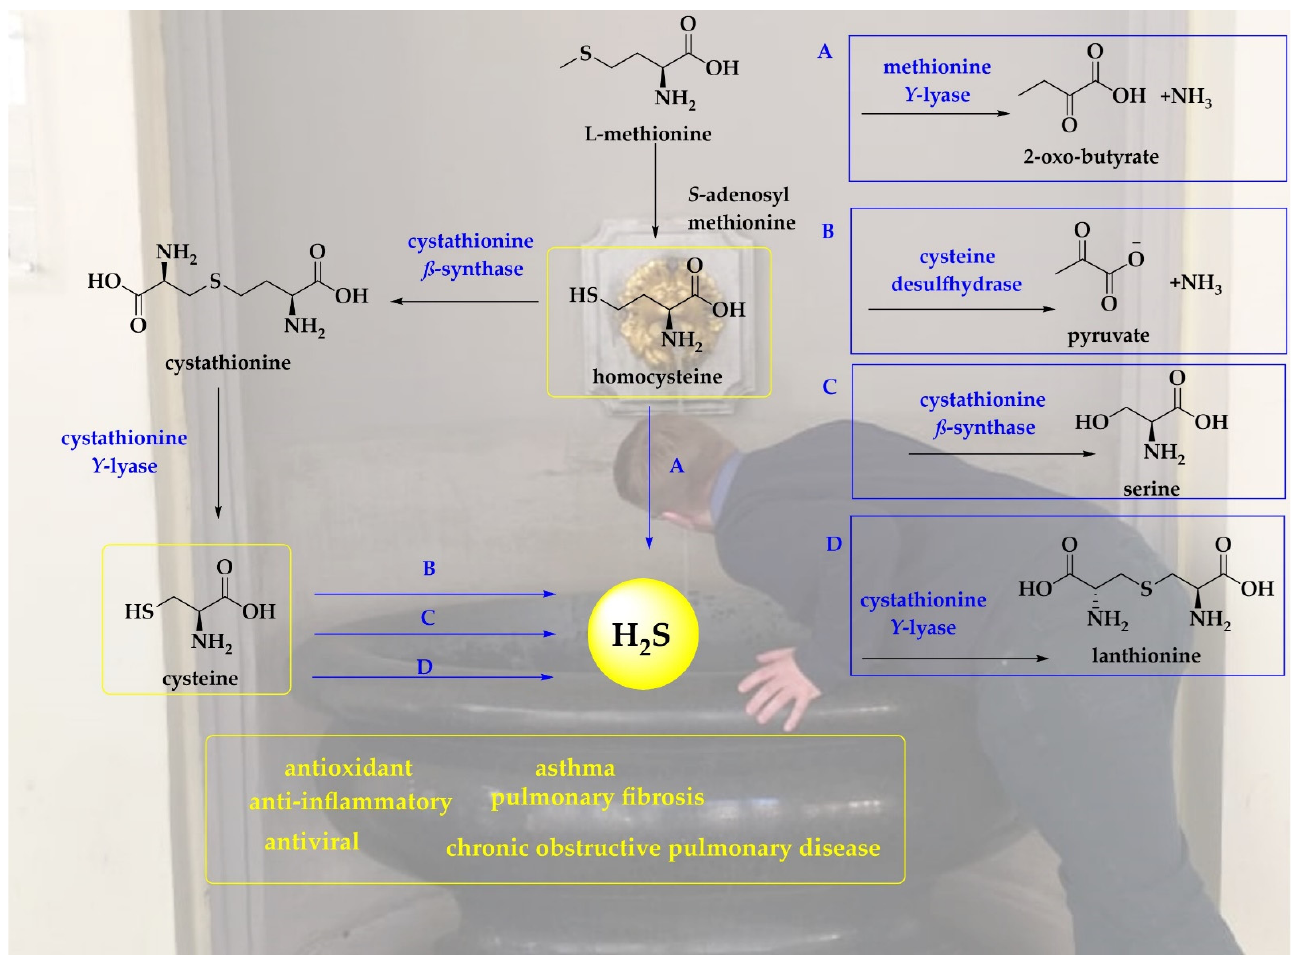
Figure 1. In mammals, H 2 S is produced via several pathways. Cystathionine- β -synthase (CBS) and cystathionine- γ -lyase (CSE) interact with cysteine to produce H 2 S following the reverse transsul- furation pathway and α , β -elimination, respectively [39,40]. The production of H 2 S also involves enzymes such as methionine- γ -lyase and cysteine desulfhydrase [24]. The scheme is superimposed on a photo of the Elisenbrunnen in the German city of Aachen, a popular source of sulfur-rich water drunk frequently by the local population (Photo credit to Muhammad Jawad Nasim) [41].